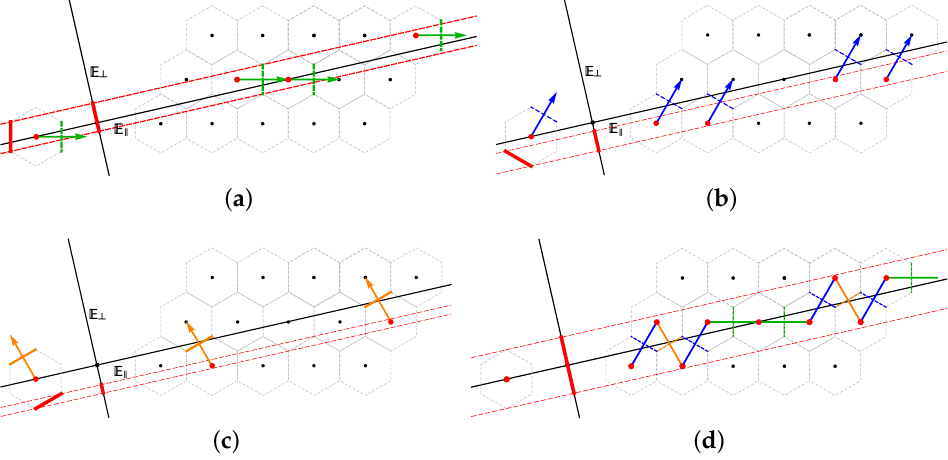
Figure 4. ( a – c ) Three of the six tile types ˜ t (colored arrows) are shown for the T ( A 2 ) along with their corresponding regions r = − ˜ t ∗ ⊥ ⊂ W (thick red lines). Any lattice point λ which falls into a region, λ ⊥ ∈ r , will be adjacent to a tile t which is a translated copy t = ( ˜ t + λ ) of the tile type ˜ t corresponding to r . ( d ) The selected tiles are shown along with the whole cut-window.